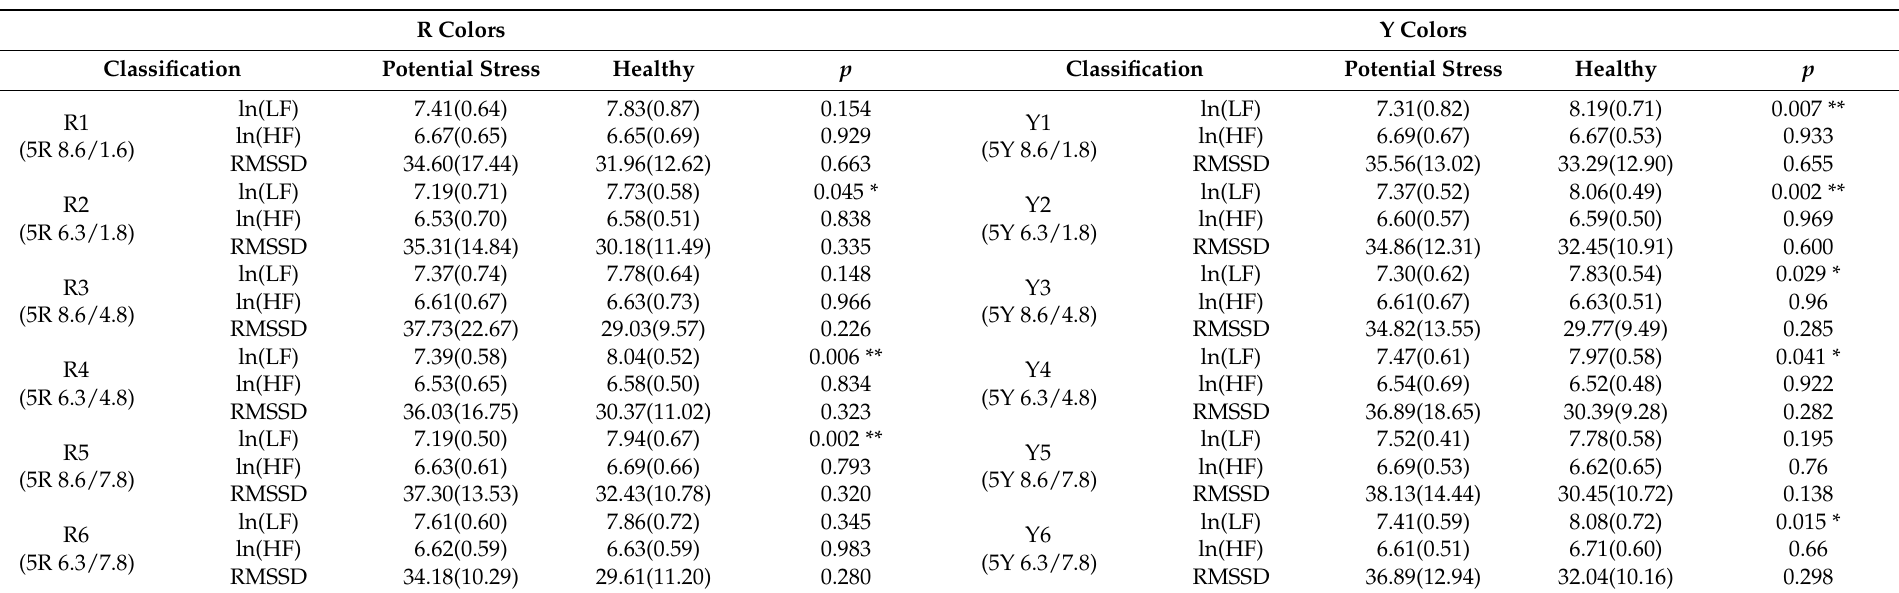
Table 10. Average ln(LF), ln(HF), and RMSSD values and t-test result subject to each environmental color for different stress